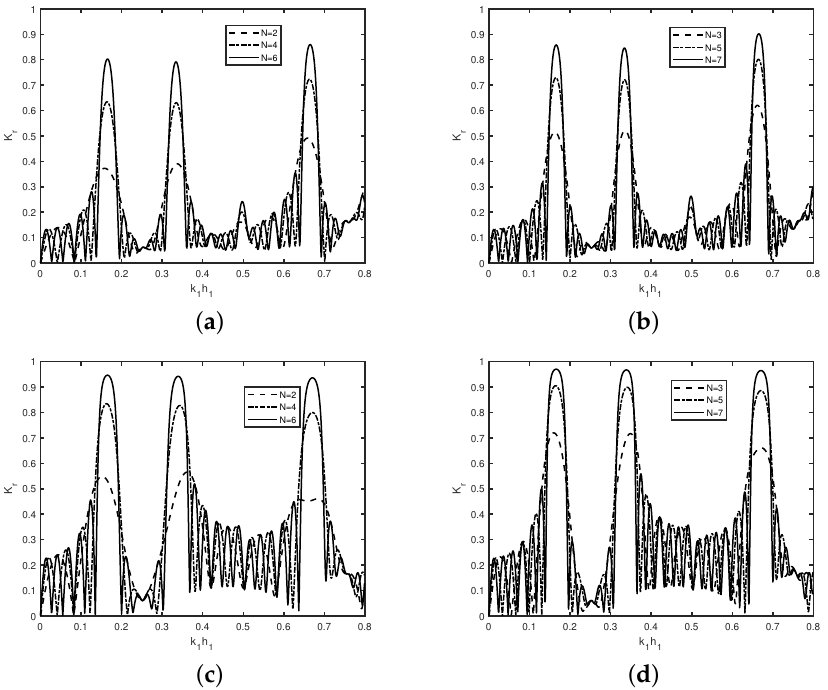
Figure 11. K r versus k 1 h 1 for different number N of ( a , b ) trenches with w / L 1 = 0.6, d / L 1 = 0.86; ( c , d ) breakwaters with w / L 1 = 0.35, d / L 1 = 0.6, in the presence of a semi-infinite plate with L g / L 1 = 0.25, D / ρ g = 10 5 m 4